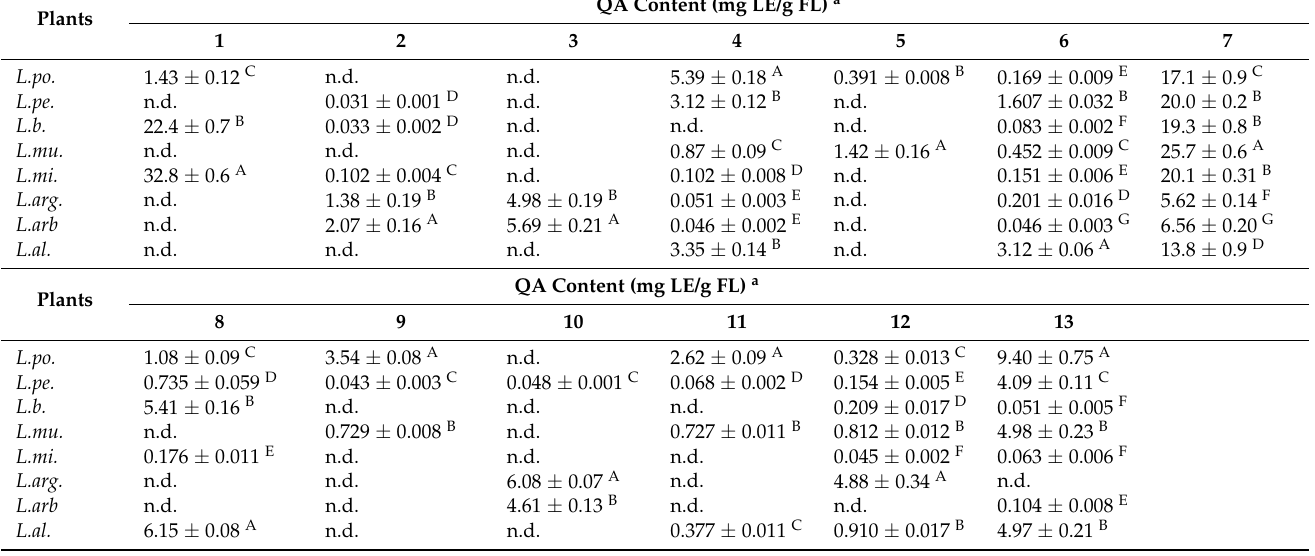
Table 2. Contents of quinolizidines 1 – 13 in leaves of eight Lupinus species. QA Content (mg LE/g FL) Plants